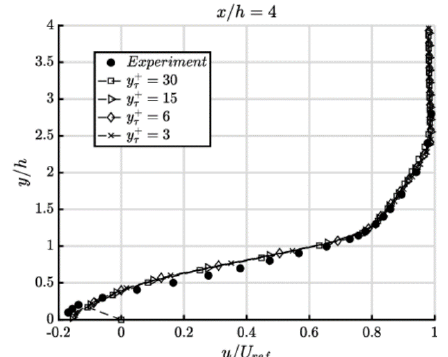
Figure 5. Streamwise velocity distributions at the location x/h = 1 as the function of normalized wall distance, y ,. The velocity was normalized by the reference velocity, U ref , defined in Reference [50] for each simulation.